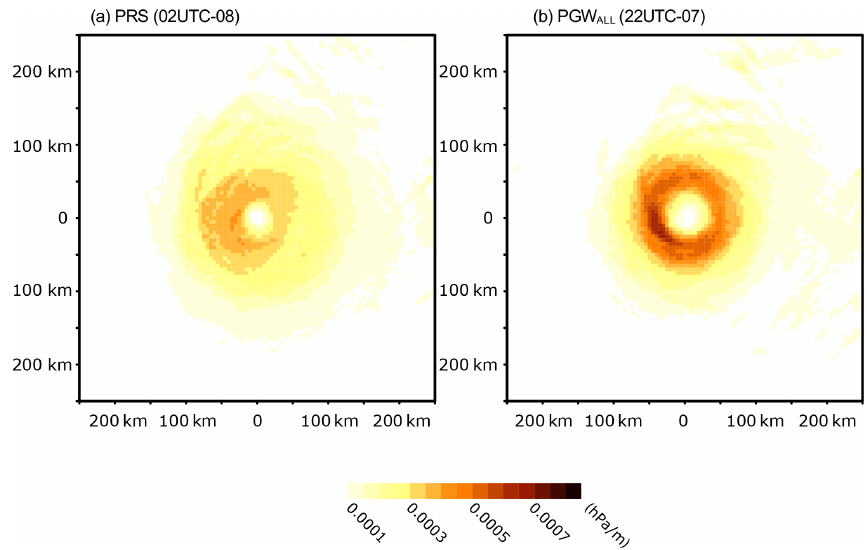
Figure 7. Scalar of SLP gradient for (a) PRS and (b) PGW ALL around the cyclone centre at SLP minimum (referring to Fig.